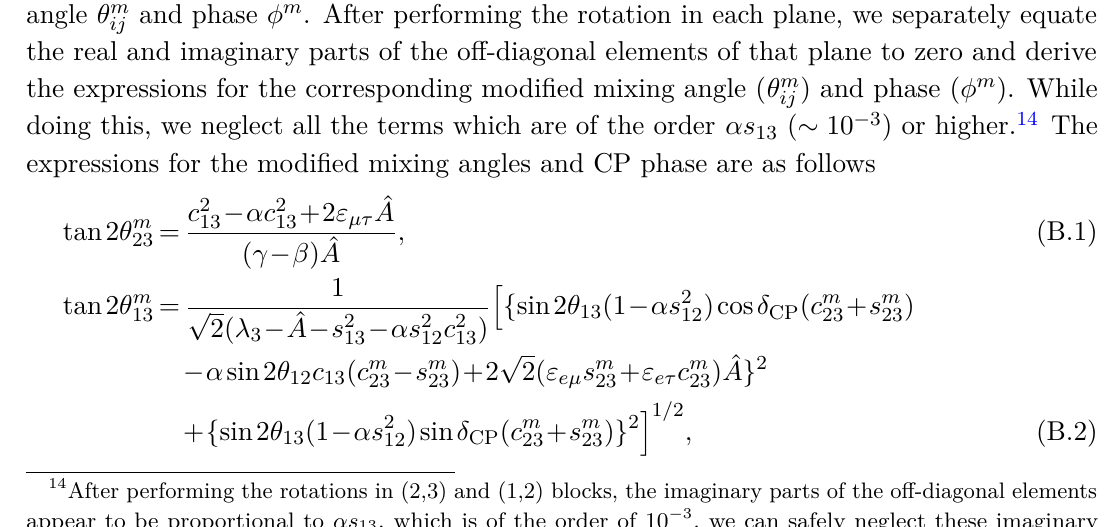
Figure 15 . Comparison of ν µ → ν µ disappearance probability estimated from our approximate analytical expressions (red curves), and the numerical calculations obtained from GLoBES (black curves) in the presence of NC-NSI parameters ( γ − β ) and ε we consider the presence of ( γ − β ) and lower panels are for ε correspond to the three different baselines: 1300 km (left panels), 5000 km (middle panels), and 8700 km (right panels). The solid (dashed) curves are obtained using a value of 0.1 ( − 0 . 1 ) for the NSI parameters. Values of the three-flavor oscillation parameters are taken from table 2. We assume θ 23 = 45 ◦ and